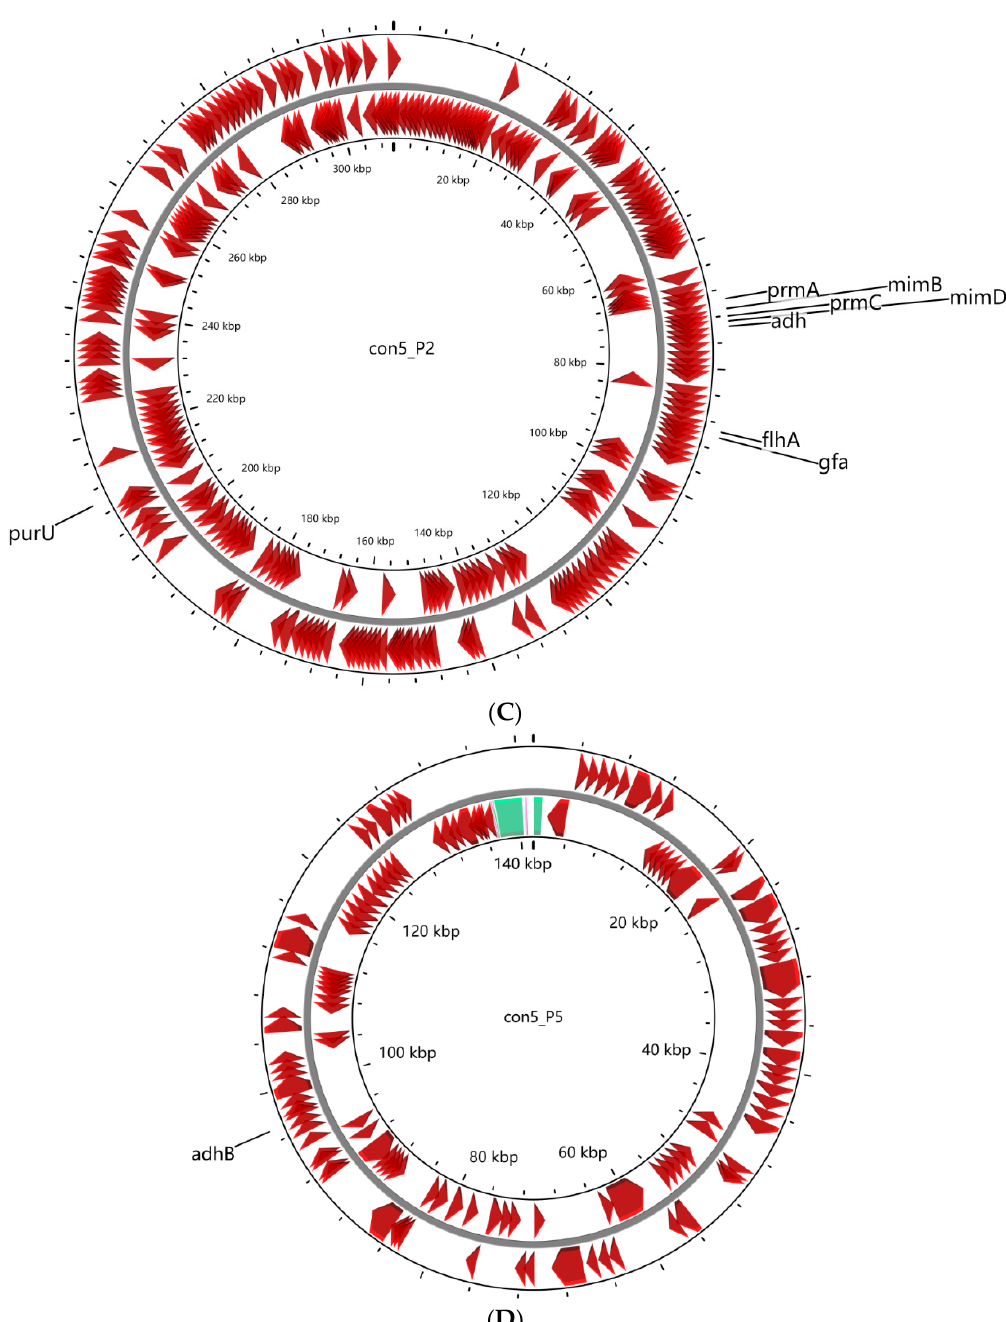
Figure 3. Graphic representation of circular chromosome ( A ) and plasmids ( B – D ) of strain con5 T . The locations of genes involved in methylotrophy are indicated at the outside of the map. The CDS (dark red), tRNA (purple), rRNA (green), and tmRNA (golden) were shown on the reverse and forward strand, respectively.